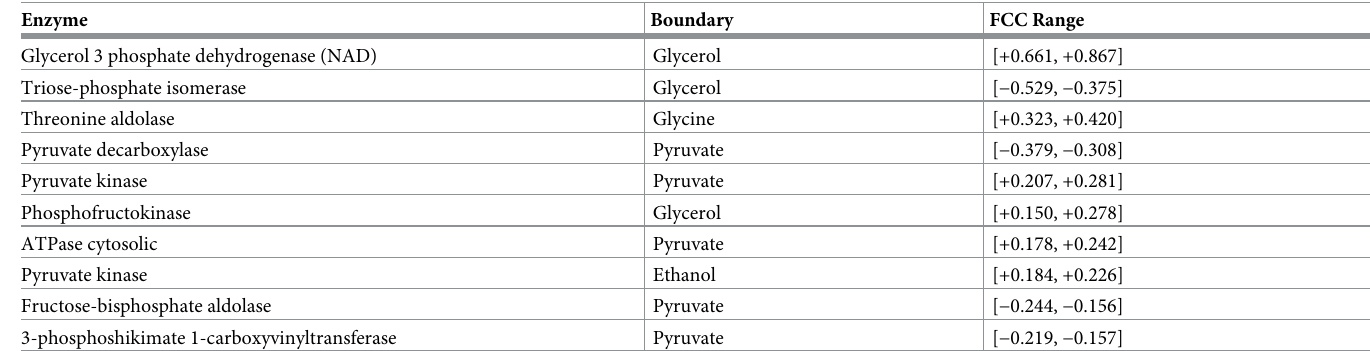
3-phosphoshikimate